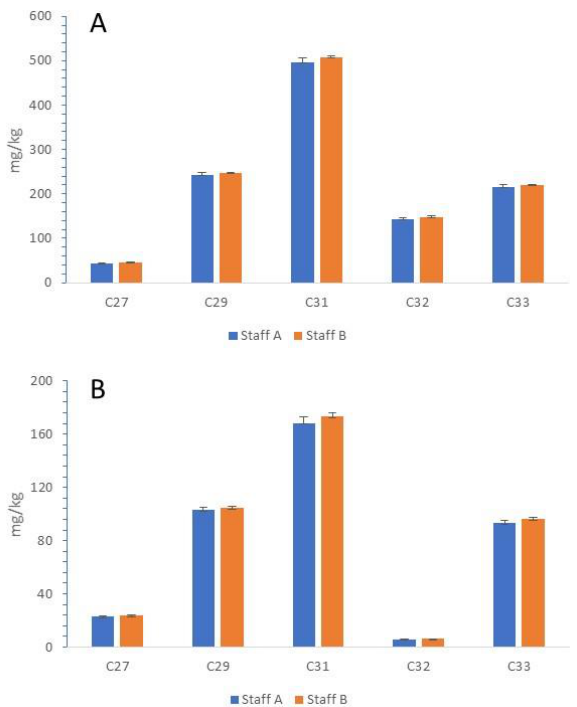
Figure 2. Comparison of the major n -alkane concentrations (C27 – C33) obtained by two operators using the miniaturised protocol. Each column is the mean of four technical replicates and error bars are standard deviations (SD). ( A ): faeces; ( B ): herbage. Note: no significant difference was found for any n -alkane between the two operators (statistical symbols omitted).